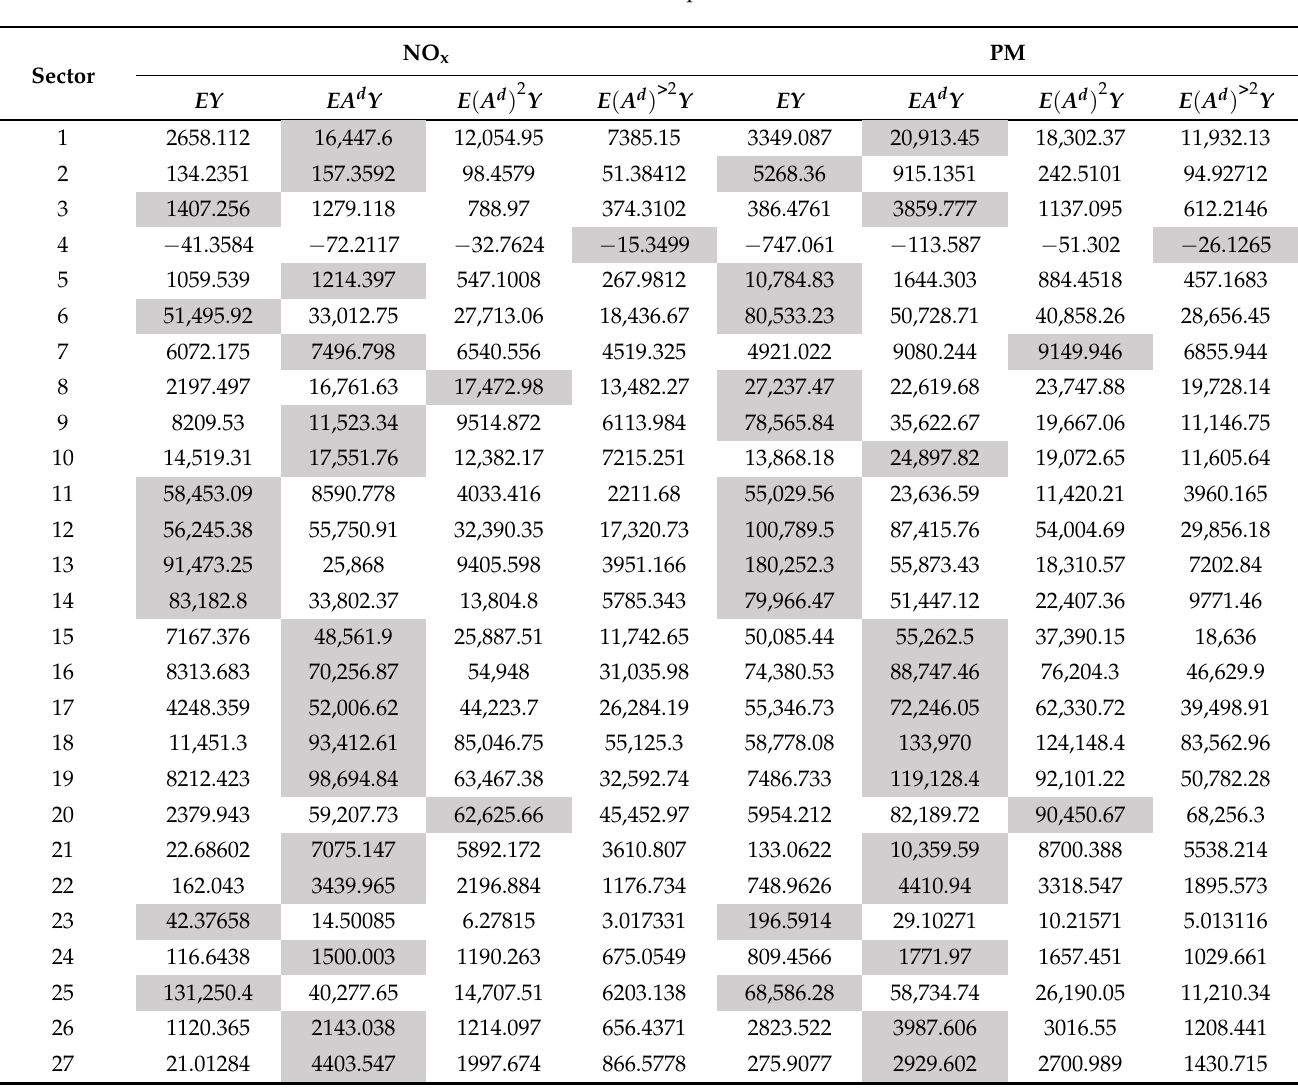
Table 4. Pollutant emission structure path of China’s industrial sector in